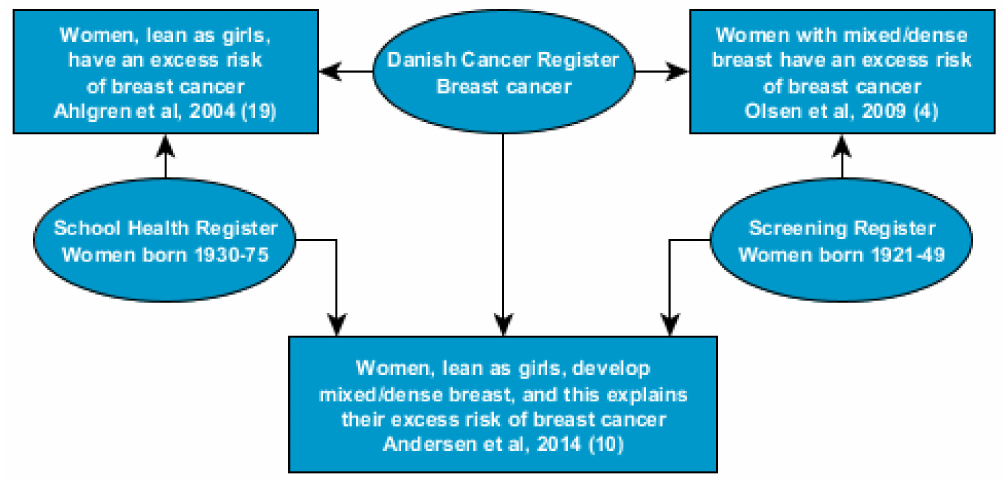
Figure 1. Danish studies on the association between childhood body constitution, mammographic density in mid-life age and risk of breast cancer. Boxes: studies; ovals: data